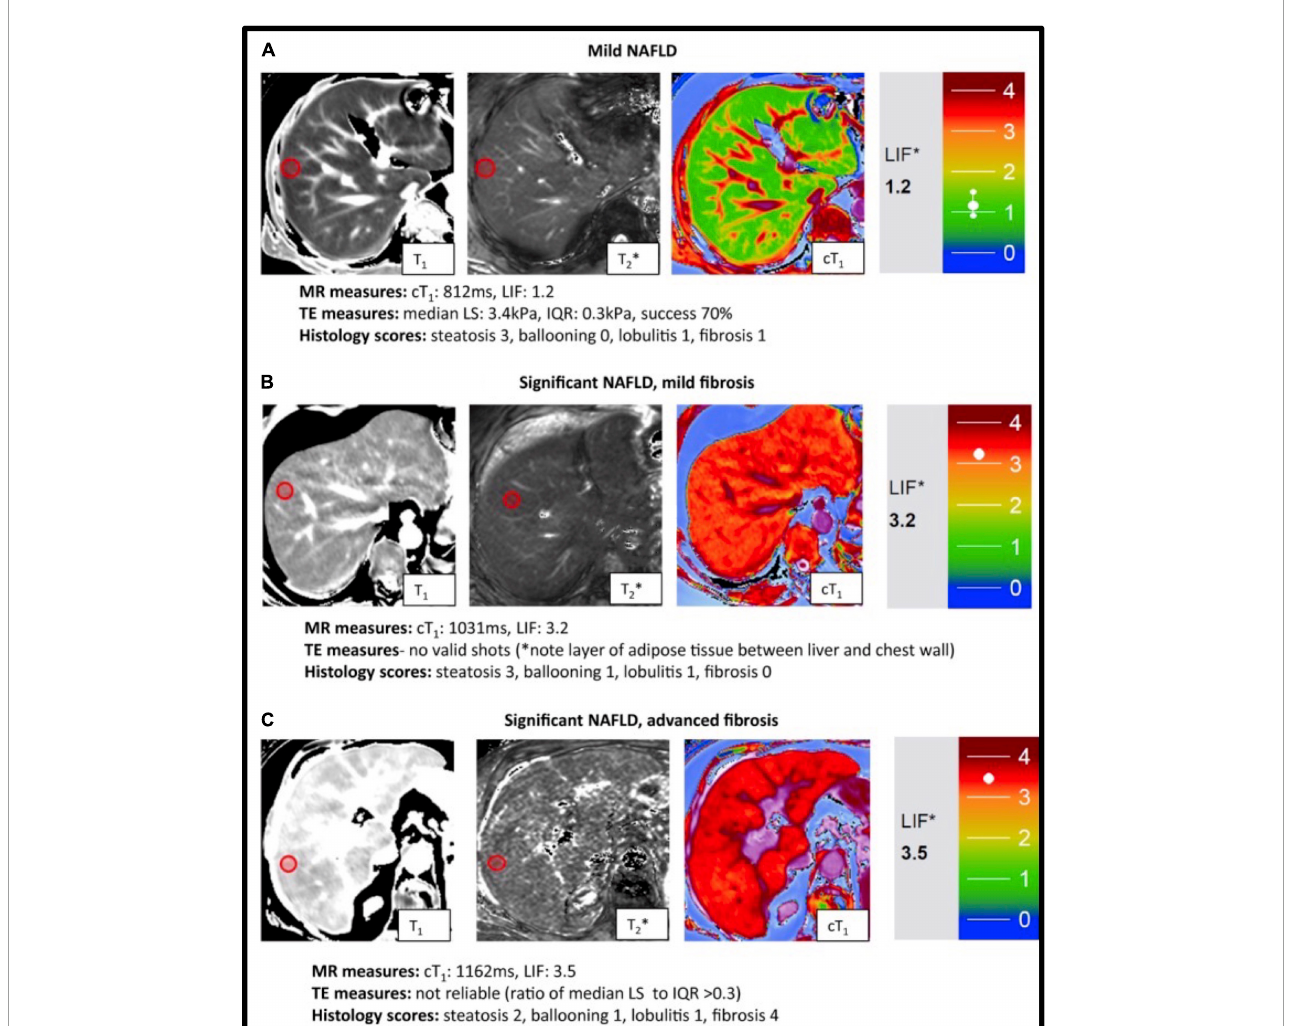
FIGURE7 Representative magnetic resonance data with the corresponding transient elastography (TE) and histology data from patients with known or suspected non-alcoholic fatty liver disease NAFLD. T1, T2 ∗ mapping values were used to derive the calculated corrected T 1 maps (cT1) maps and Liver Inflammation and Fibrosis (LIF) scores. Patients were classified based on biopsy findings, using the Fatty Liver Inhibition of Progression (FLIP) algorithm (92), as having: mild disease (A) , significant disease/mild fibrosis (B) and significant disease/advanced fibrosis (C) . Red circles indicate typical regions of interest. There was a significant association between histological fibrosis and MRI LIF scores. Adapted from Pavlides et al. with permission